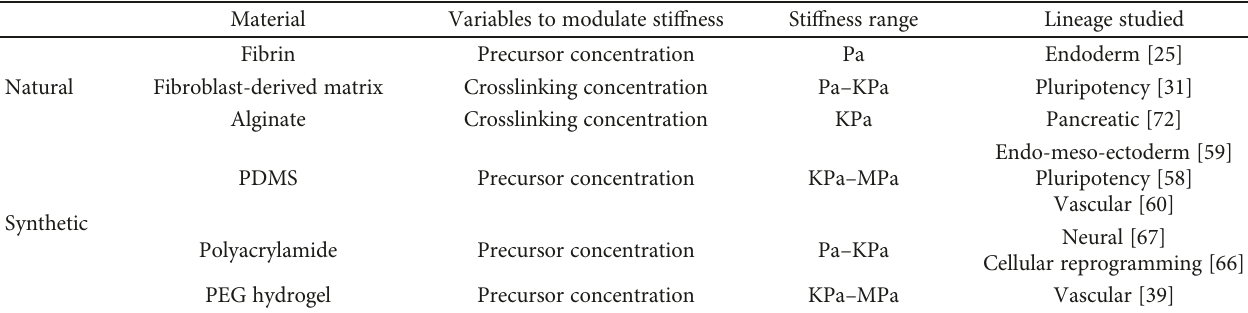
Table 3: Biomaterials and controlled sti ff ness to modulate PSC